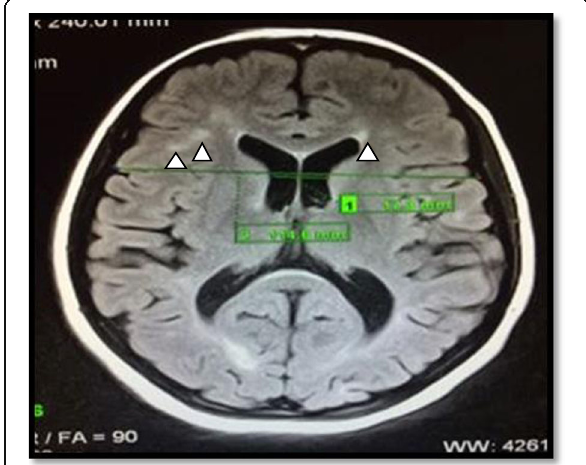
Fig. 3 Twenty-three-year-old female patient with relapsing-remitting MS. axial FLAIR image shows multiple peri-ventricular and sub- cortical demyelination patches (arrowheads). BCR =